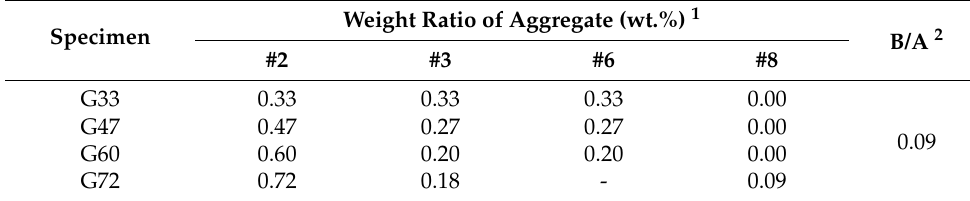
Table 2. Mix ratio of the polyurethane-based PPM. Weight Ratio of Aggregate (wt.%) 1 Specimen